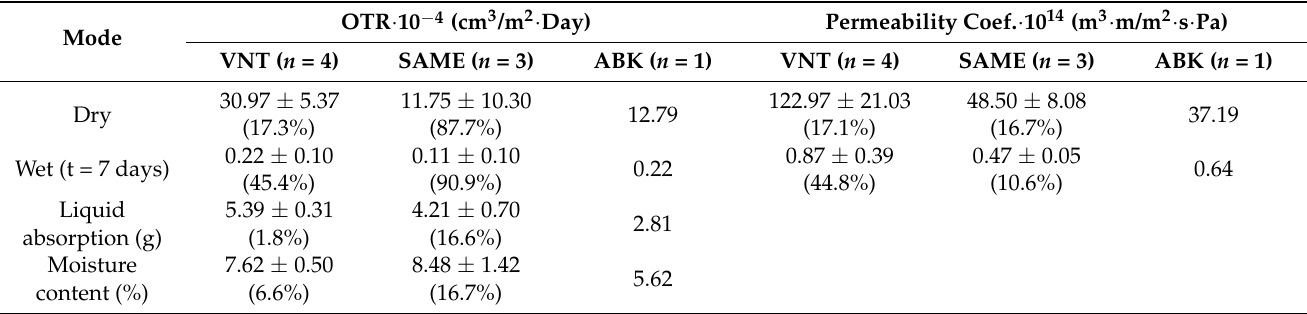
Table 3. Main permeation characteristics of tested Qvevri samples from different regions in Georgia.